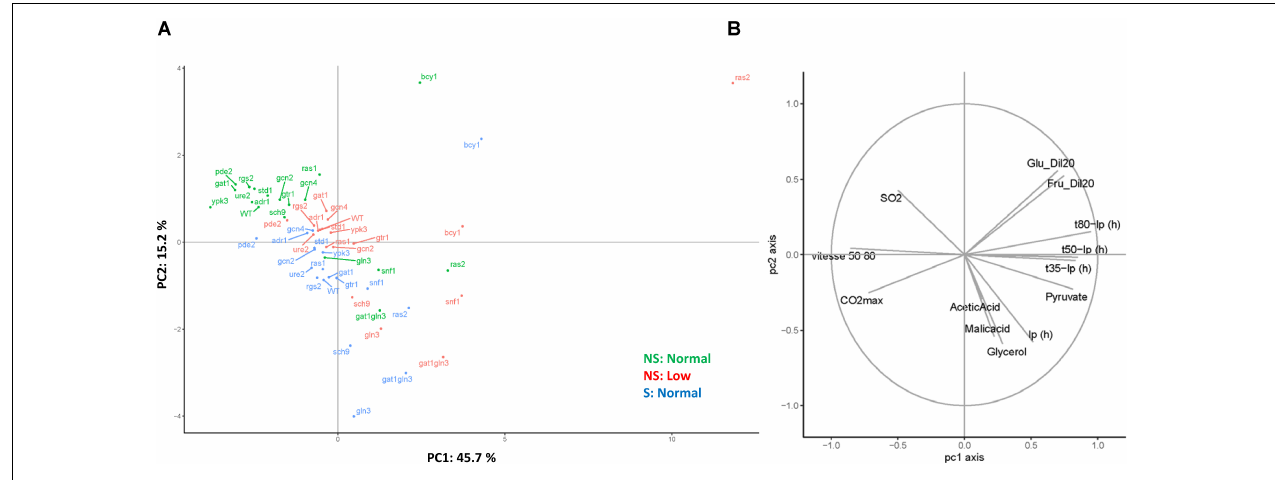
FIGURE 3 | PKA mutants have a huge impact on wine fermentation. (A) The PCA analysis of the mutants on the nutrient signaling pathways with the three fermentations: NS:Normal (green), NS: Low (red) and S:Normal (blue). (B) The correlation circle of the employed kinetic and enological parameters.